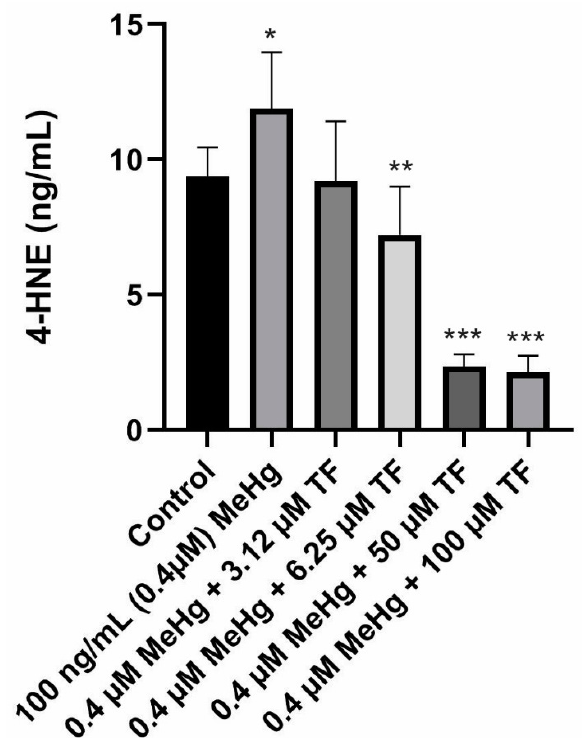
Figure 4. 4-HNE secretion in all six populations from Day 18 to Day 28. Overall statistically significant di ff erence was determined using the Kruskal–Wallis method and p -value was less than 0.0001. Di ff erences are considered significant (*) if p-value is less than or equal to 0.00625, very